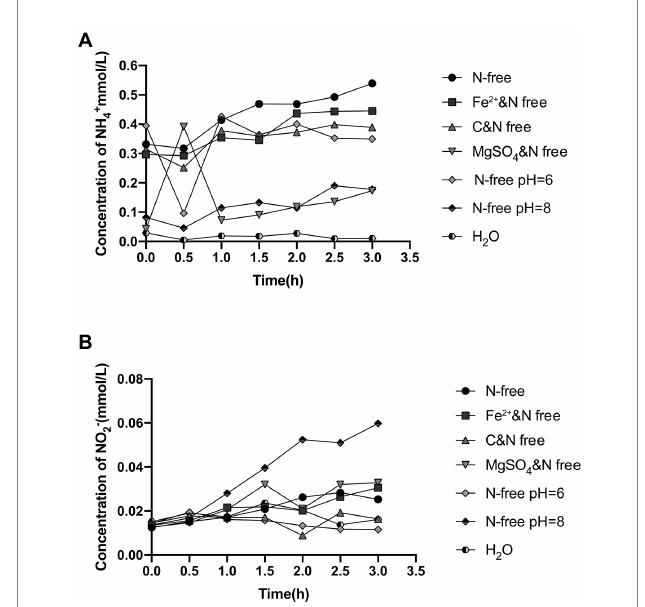
FIGURE 2 Extracellular ammonium and nitrite concentrations in different nitrogen-free media after 114 h of incubation with strain 24S4–2. (A) extracellular ammonium concentration and (B) extracellular nitrite